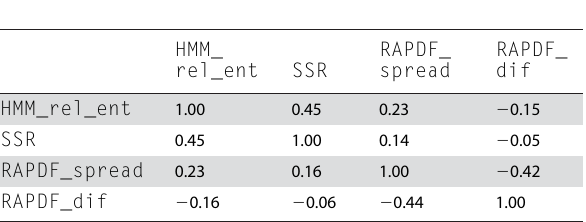
Table 1. Correlation coefficients of several components of the MFS method in the Thornton dataset (cells in upper-right triangle of the table) and the Lovell dataset (lower-left triangle),